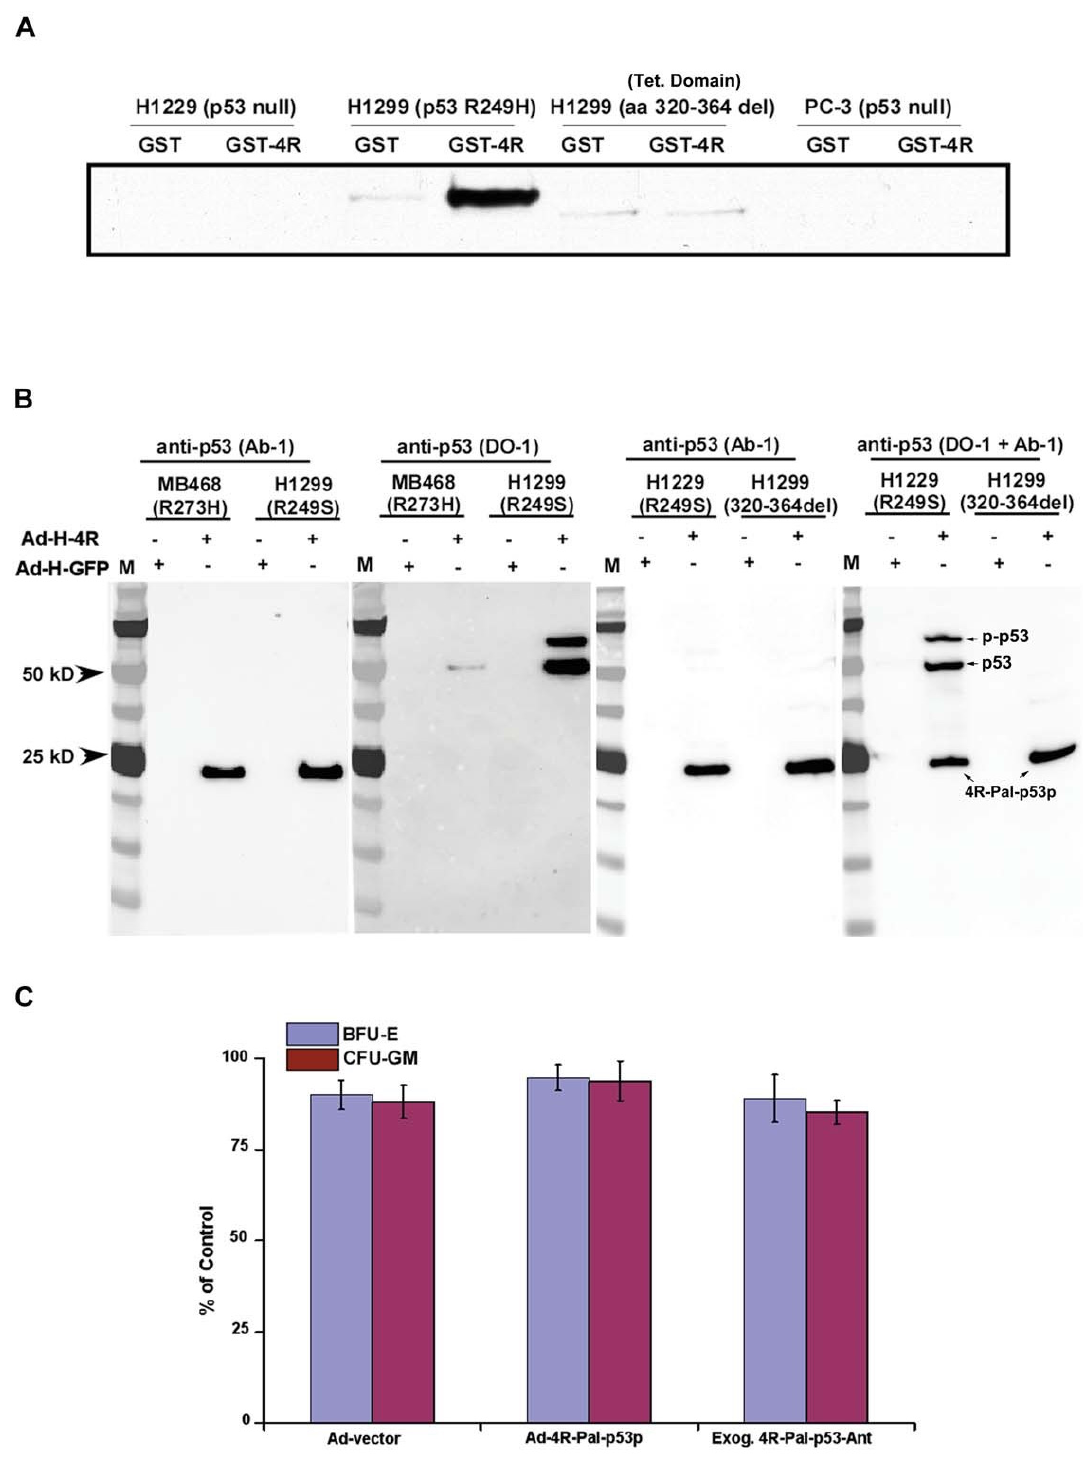
Figure 5. ( A ) Co-immunoprecipitation . This was performed to determine localization of binding to p53. It was performed with antibody to recombinant GST protein and immunoprecipitated and analyzed by Western blot with antibody to the N-terminus to p53 (DO-1 mouse IgG, epitope aa 21–25). Only GST-4R-Pal-p53p co-immunoprecipitated with mutant p53, whereas GST alone did not. This suggested that 4R-Pal-p53p binds to mutant p53. ( B ) Determination of binding site of peptide to p53. To determine where the 4R-Pal-p53p binds to p53, H1299 stable cell lines with p53 (R249S), and WT p53 deletion mutant (tetramerization domain deletion aa 320–364) and MB648 with mutant p53 (R273H) were infected with pAd/CMV/6xHis-GFP or pAd/CMV/6xHis-4R-Pal- p53p for 24 h. Co-precipitation was performed with nickel columns to recombinant His protein.